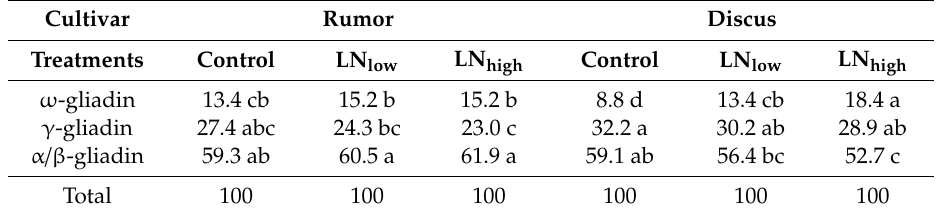
Table 4. Relative distribution of the gliadin subunits (% of total gliadins) in response to late N application (Control, LN low , LN high ) for the two cultivars Rumor and